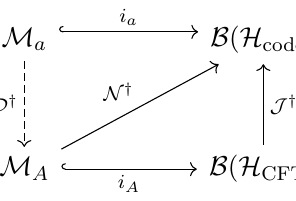
i i Figure 2 . In the Heisenberg picture, M a , ! B ( H code ) and M A , ! B ( H CFT ) are von Neumann subalgebras acting on the code space H code and CFT Hilbert space H CFT respectively. The Heisenberg channel J y = J y ( (cid:1) ) J maps boundary observables to their projection in the code space. The task of entanglement wedge reconstruction is to (cid:12)nd a Heisenberg decoding channel D y : M a ! M A that maps bulk observables (cid:30) a in M a to boundary observables (cid:8) A in M A .